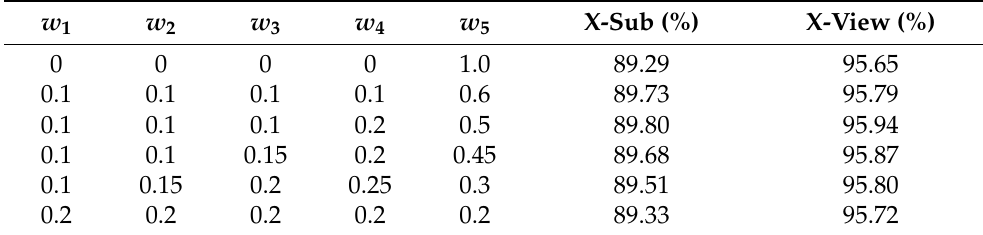
Table 5. Action recognition accuracy on the NTU-RGB+D dataset of MS-ASGCN with distinct fusion weights.